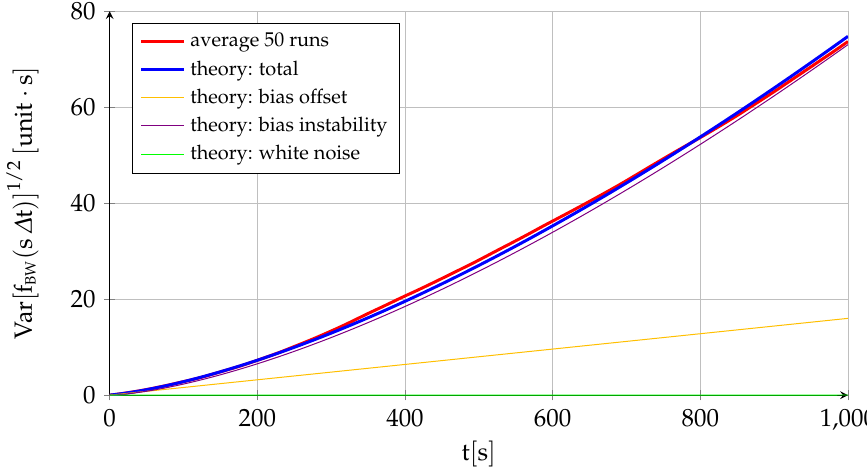
Figure 5. Propagation with time of first integral of sensor error standard deviation.